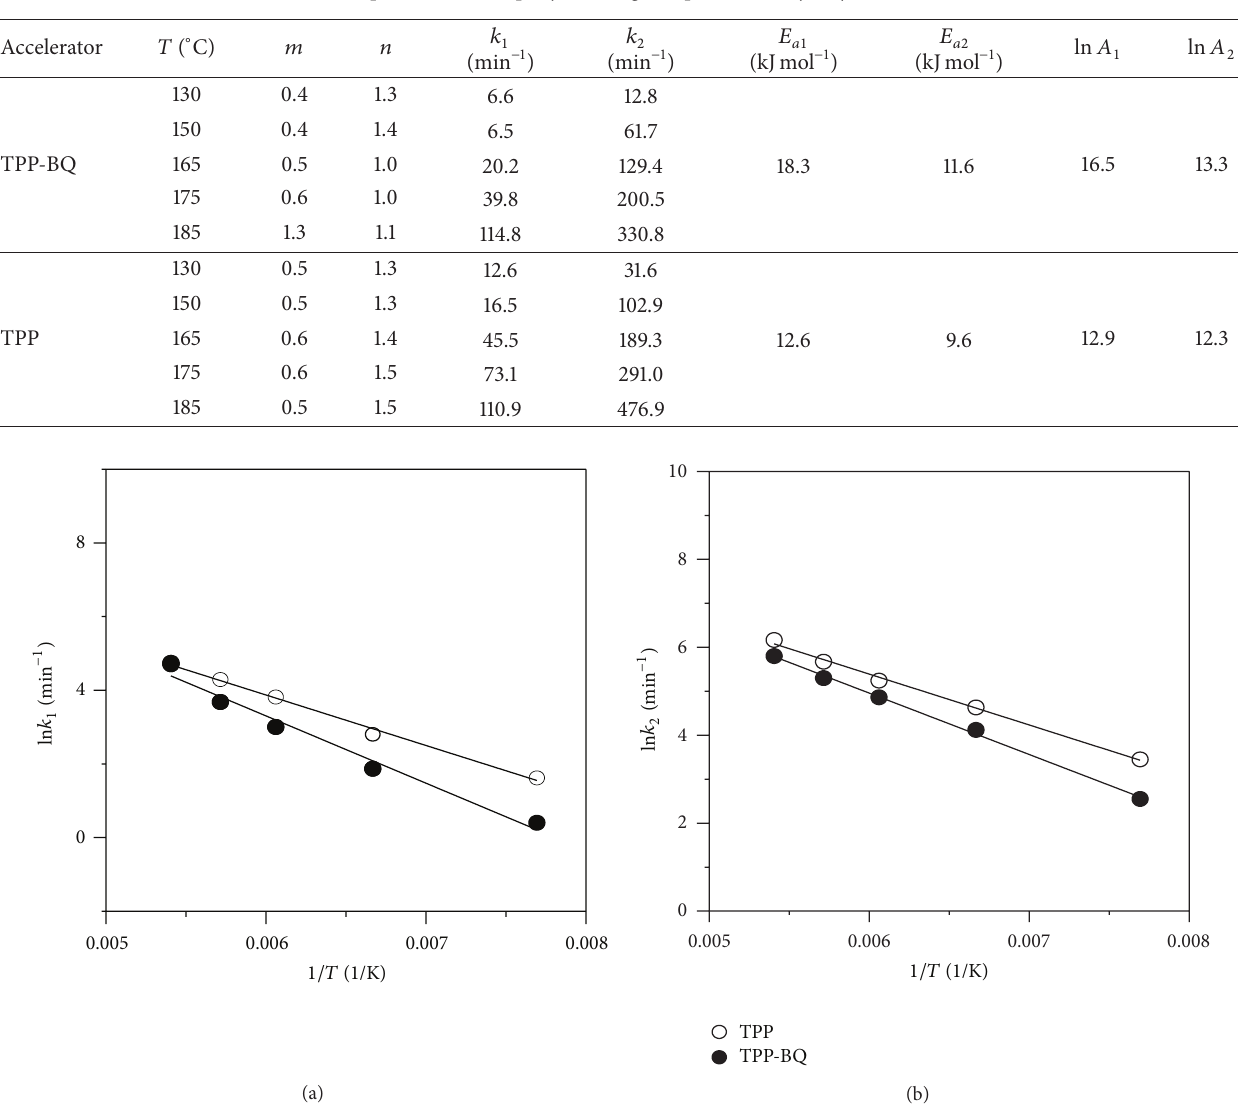
Figure 4: Kinetic analysis for organophosphine accelerators-cured EMCs in an autocatalysed reaction: (a) plots of ln 𝑘 1 against 1/𝑇 and (b) plots of ln 𝑘 2 against 1/𝑇 ,